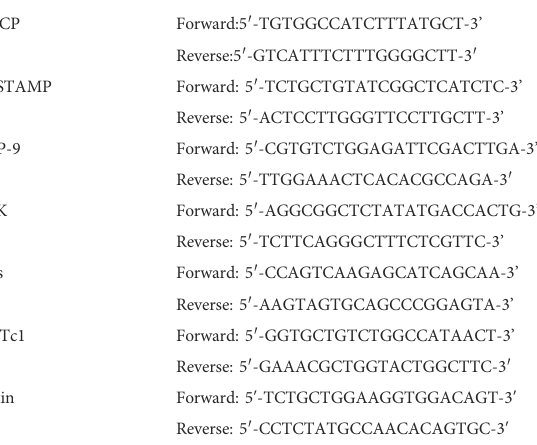
TABLE 1 The primer sets used are as